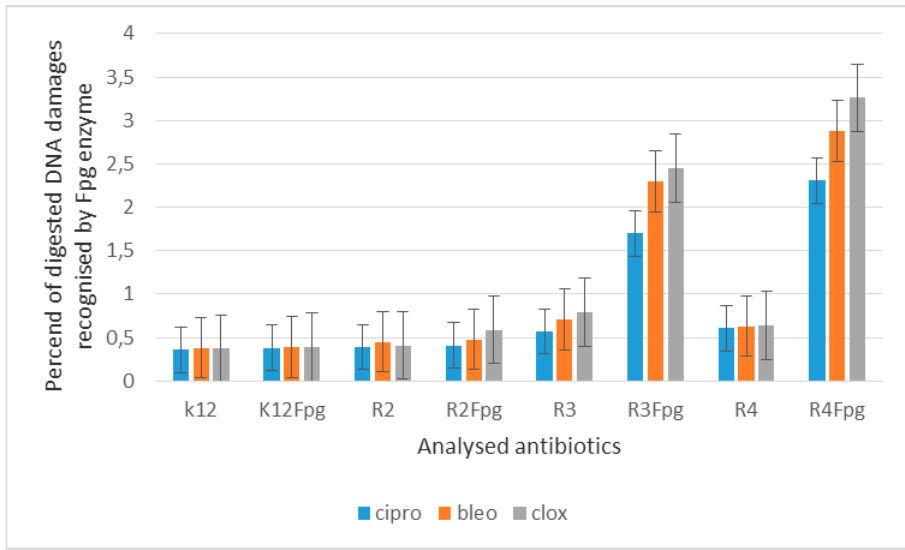
Figure 10. Percentage of bacterial DNA recognized by Fpg enzyme in model bacterial strains after ciprofloxacin, bleomycin, and cloxacillin treatment. The compounds were statistically significant at p < 0.05.